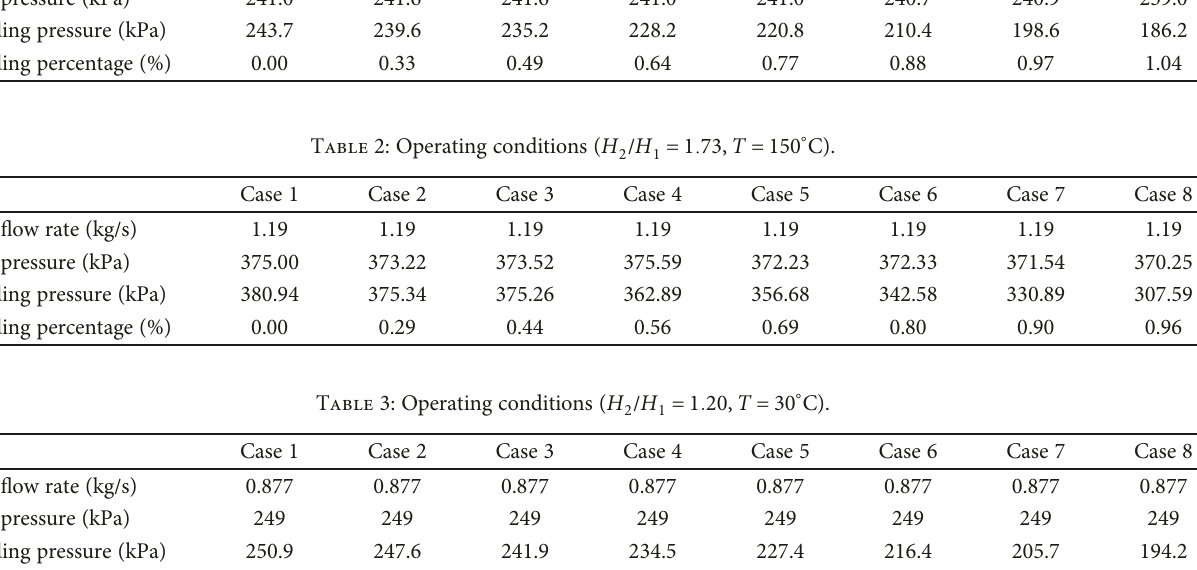
Table 1: Operating conditions ( H